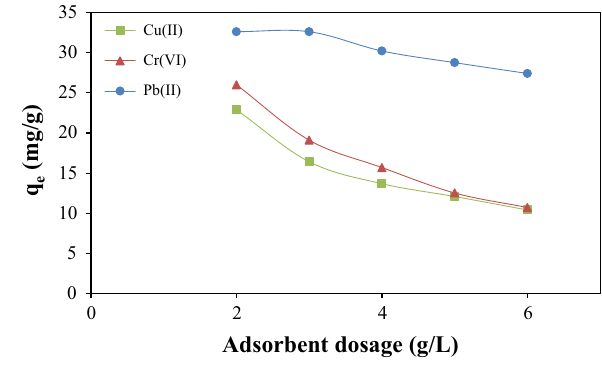
Fig. 7 Effect of solution pH on uptake amounts of Cu (II), Cr(VI) and Pb(II)